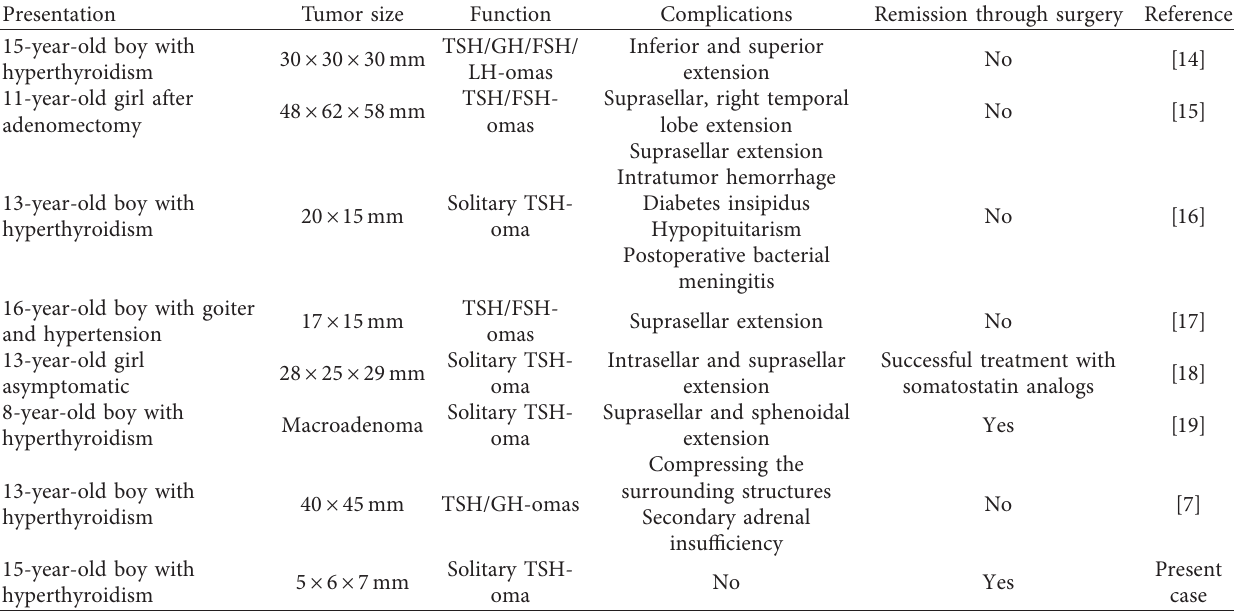
Table 3: Summary of the 7 cases reported in the literature of pediatric TSH-secreting pituitary adenomas and the present case.